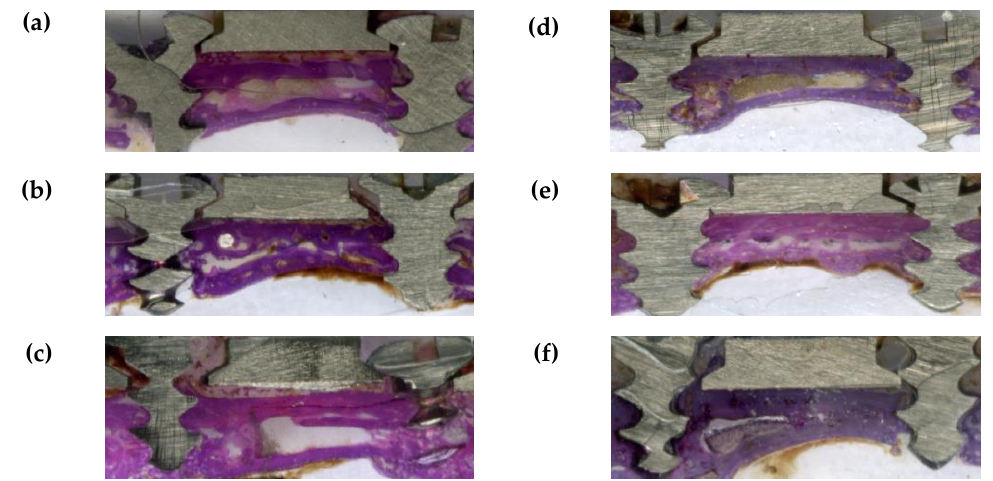
Figure 12. ( a – c ) Hematoxylin and eosin (H&E) staining of the tissue around the plates after four weeks